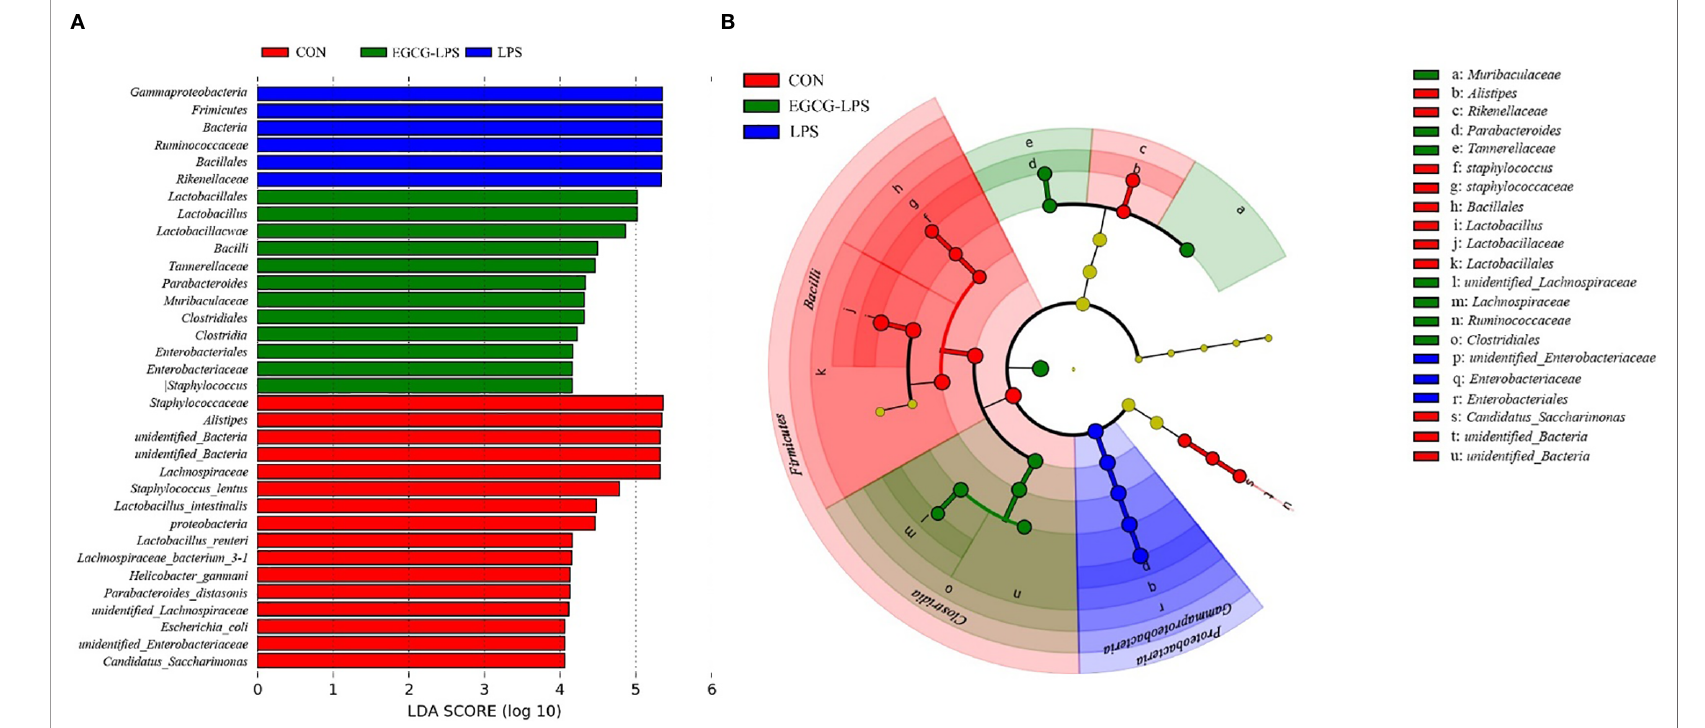
FIGURE 6 | Characteristic of mouse colon microorganisms determined by intragastric administration of EGCG. (A) LDA score, an LDA score higher than 4 was considered to be an important contributor to the model; (B) LEfSe taxonomic cladogram, different colors suggest enrichment of certain taxa in the control group (red), LPS group (blue) and LPS-EGCG group